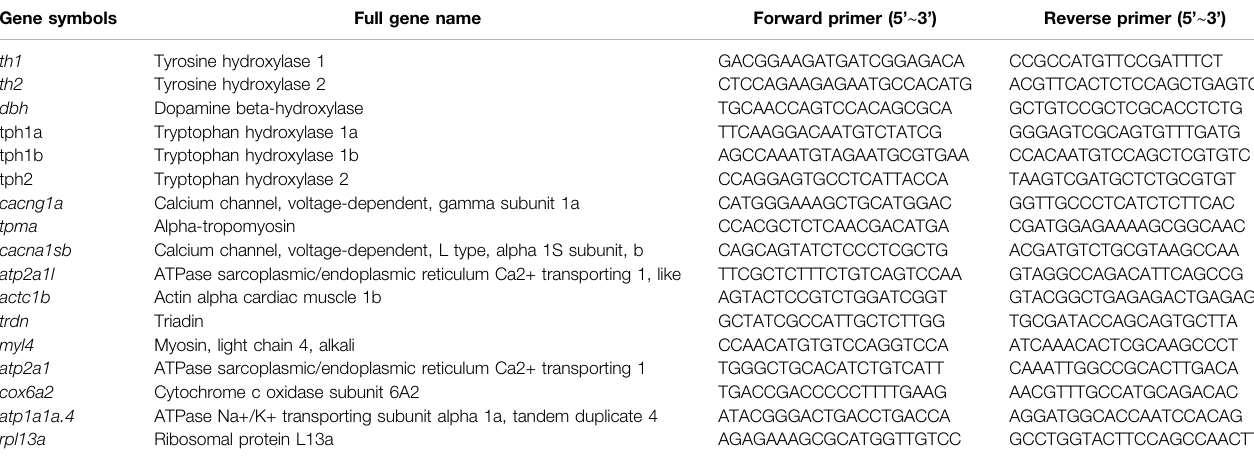
TABLE 1 | List of the primers for RT-PCR